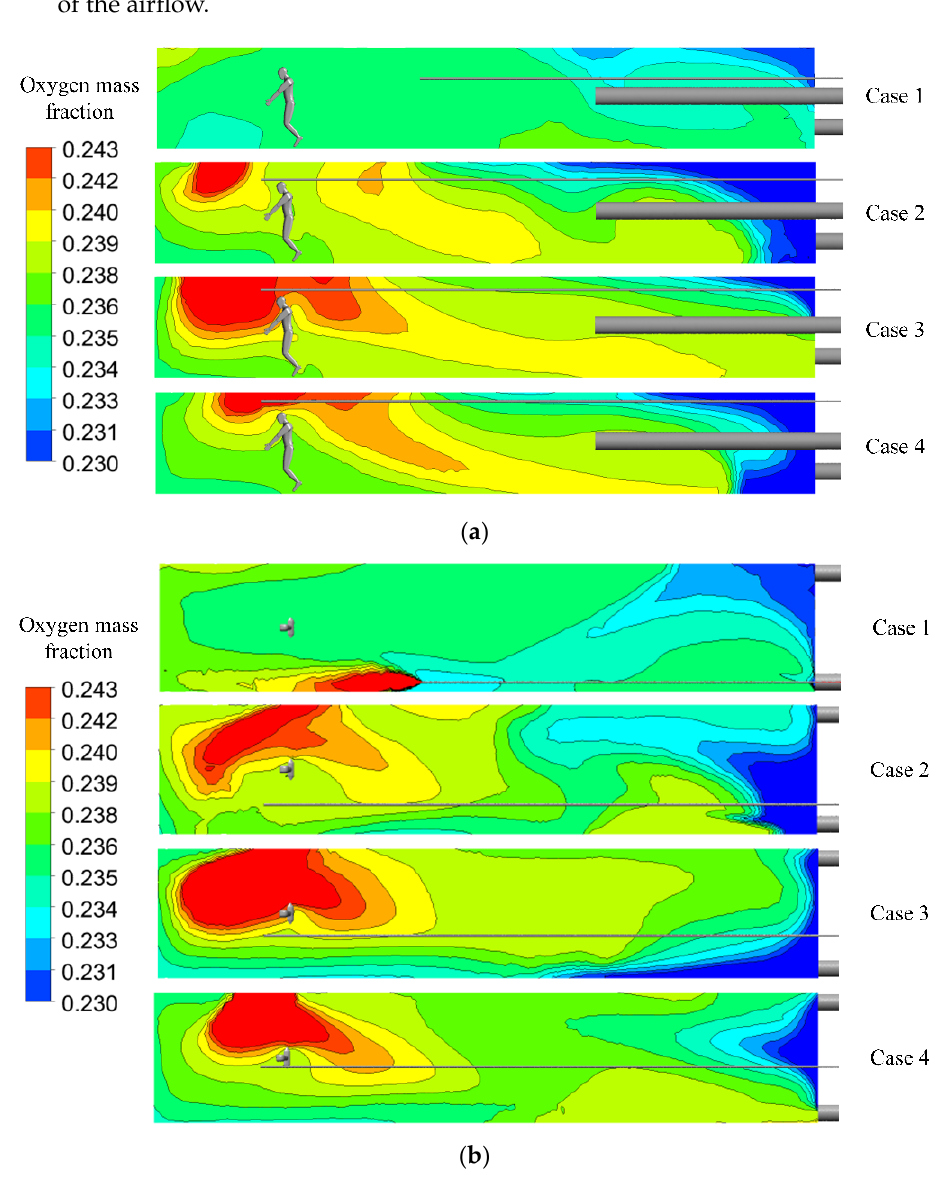
Figure 6. Distributions of oxygen mass fractions. ( a ) Distribution of oxygen mass fractions at section X = 0 m. ( b ) Distribution of oxygen mass fractions at section Y = 1.6 m.